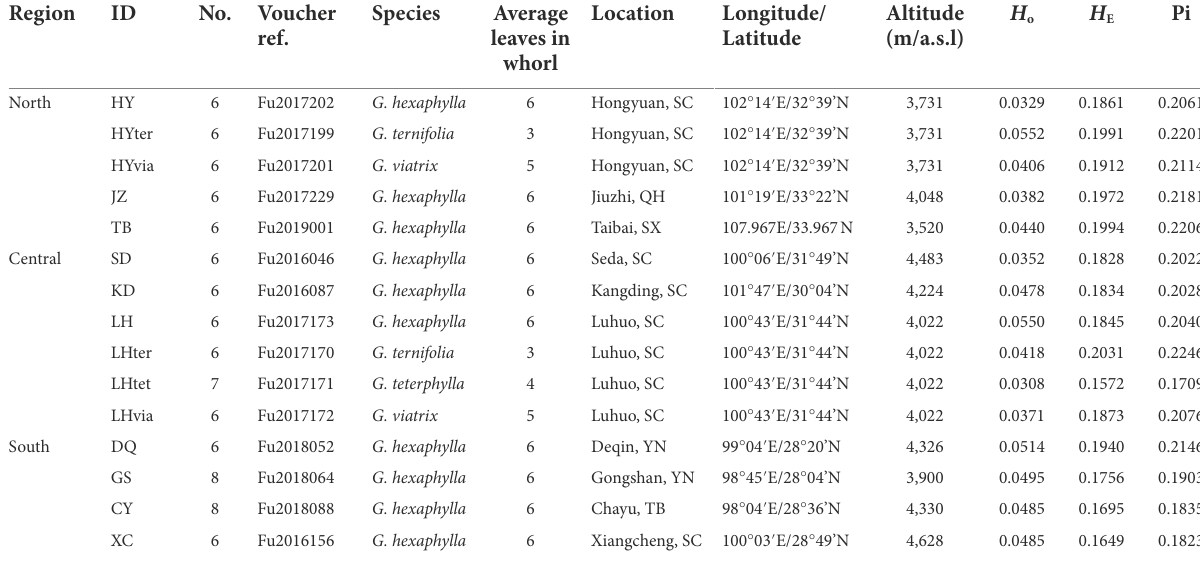
TABLE 1 Information of samples and genetic diversity in this study. Region ID No. Voucher